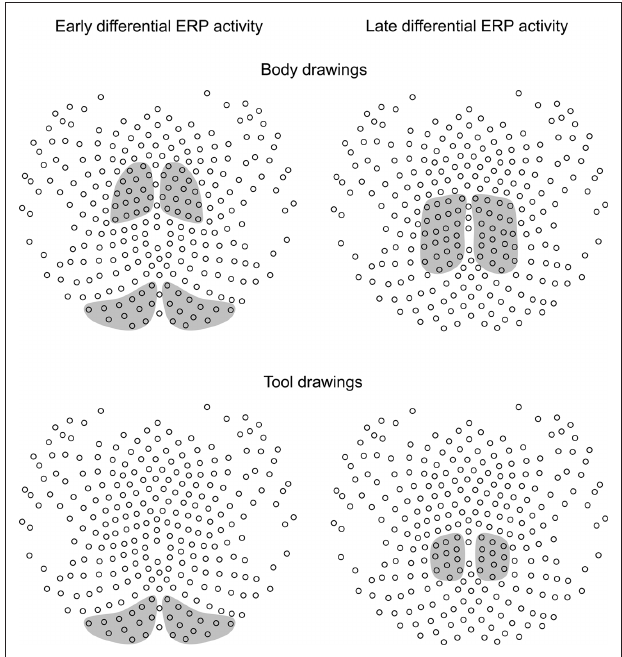
FiguRE 2 | illustration of the sensor-montage of the high-density EEg-system. Gray areas indicate sensor clusters used to calculate mean ERP activity regarding early and late differential ERP activity associated with body and tool stimulus